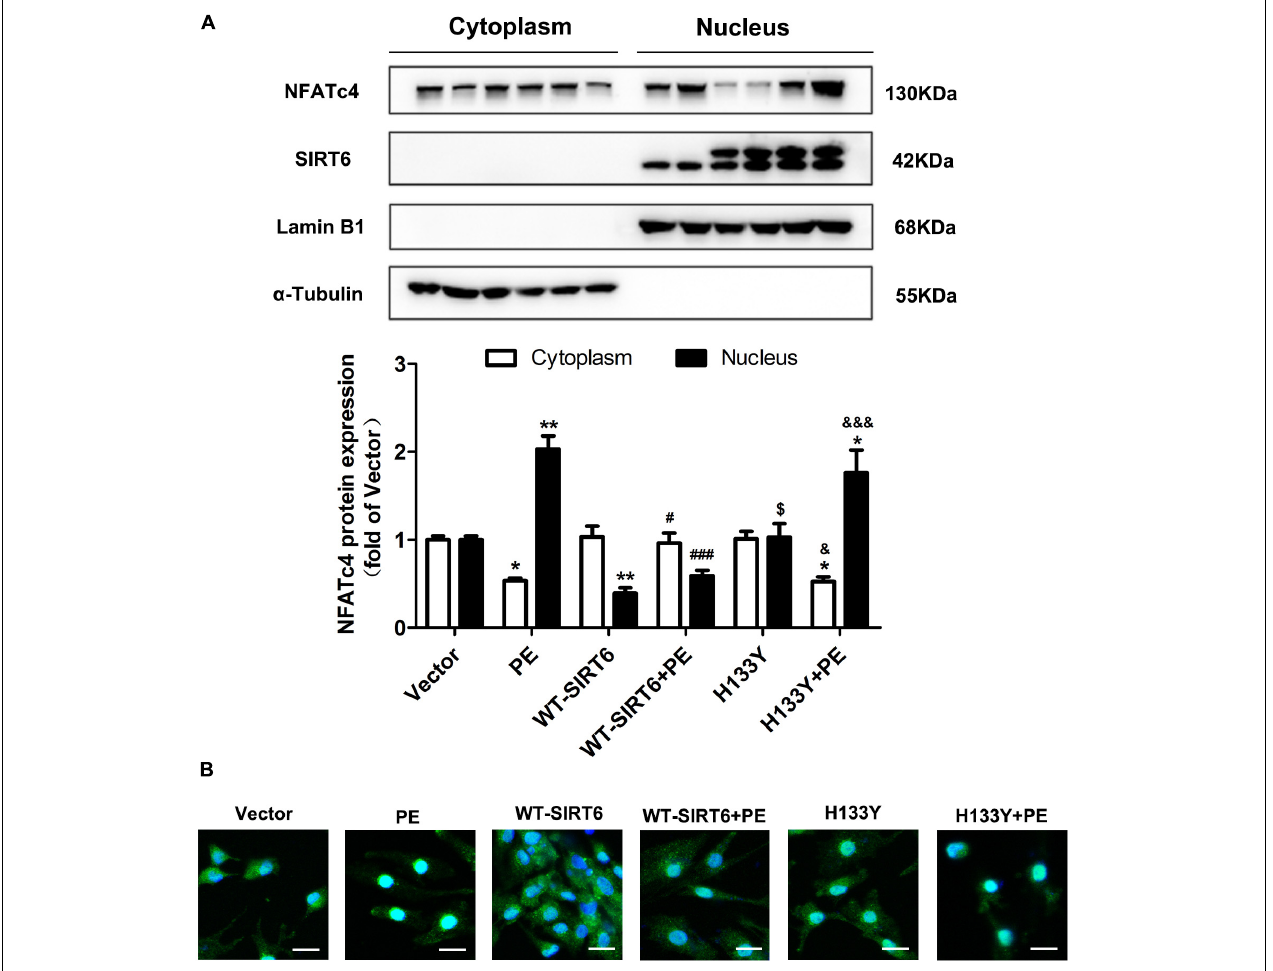
FIGURE 5 | SIRT6 prevented PE-induced nuclear translocation of NFATc4 by interfering with calcineurin-NFATc4 interaction. NRCMs were transiently transfected with plasmid encoding the WT-SIRT6 and mutant of SIRT6 (H133Y) for 48 h followed by incubation with PE (100 µ M for 12 h). (A) The protein expression of NFATc4 in the nucleus and cytoplasm was measured by Western blotting. (B) The presence of shuttling between the nucleus and cytoplasm of NFATc4 was observed by IF microscopy. The results were normalized to those of α -tubulin/LaminB1. The data were presented as mean ± SEM. ∗ P < 0.05, ∗∗ P < 0.01 vs. Vector. # P < 0.05, ### P < 0.001 vs. PE. $ P < 0.05 vs. WT-SIRT6. & P < 0.05, &&& P < 0.001 vs. WT-SIRT6 + PE. n =